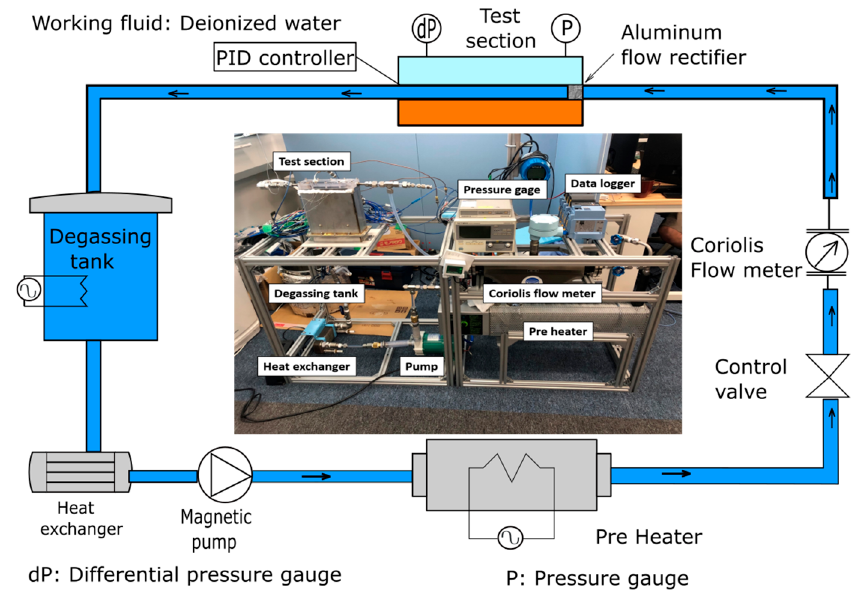
Figure 1. Schematic diagram of the experimental apparatus.